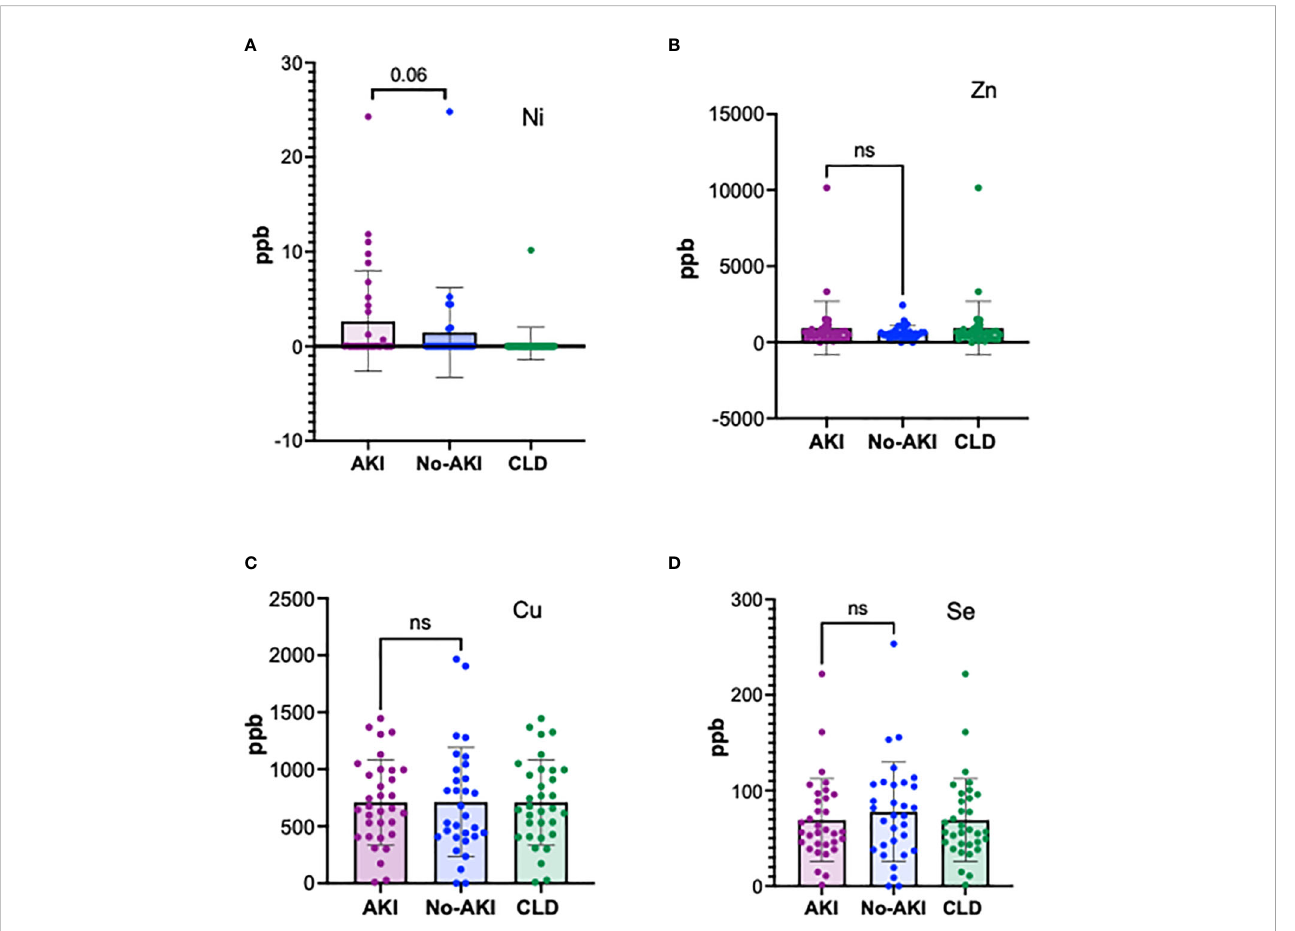
FIGURE 3 Plasma elemental analysis by ICP-MS for (A) Ni, (B) Zn, (C) Cu and (D) Se. The levels of the metal ions are not signi fi cantly different in ACLF patients with and without AKI showing that heavy metal toxicity is not the cause for MT induction in ACLF. A fraction of ACLF-AKI patients had elevated levels of Ni (A) . ns = non-signi fi